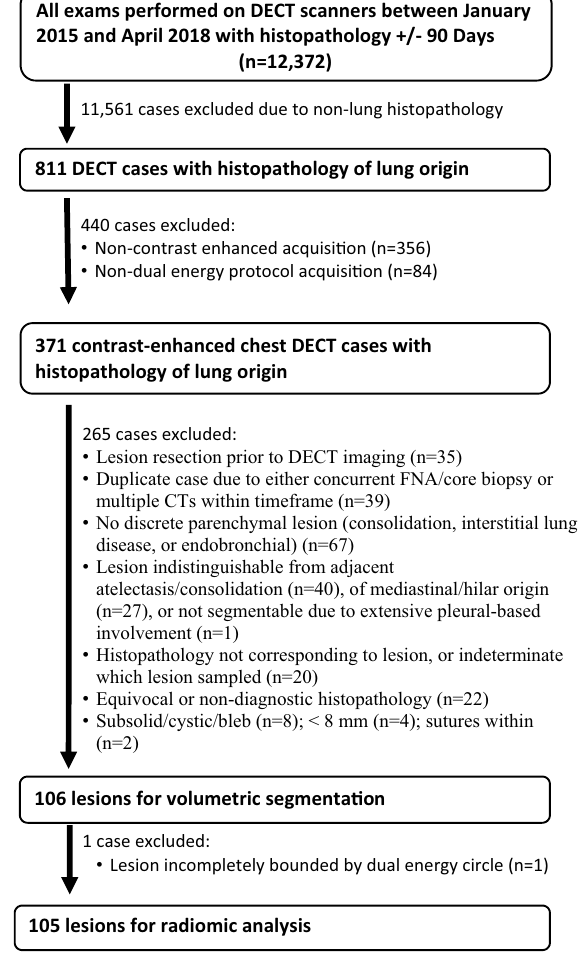
Figure 1. Flowchart of lesion selection and exclusion criteria. DECT dual energy computed